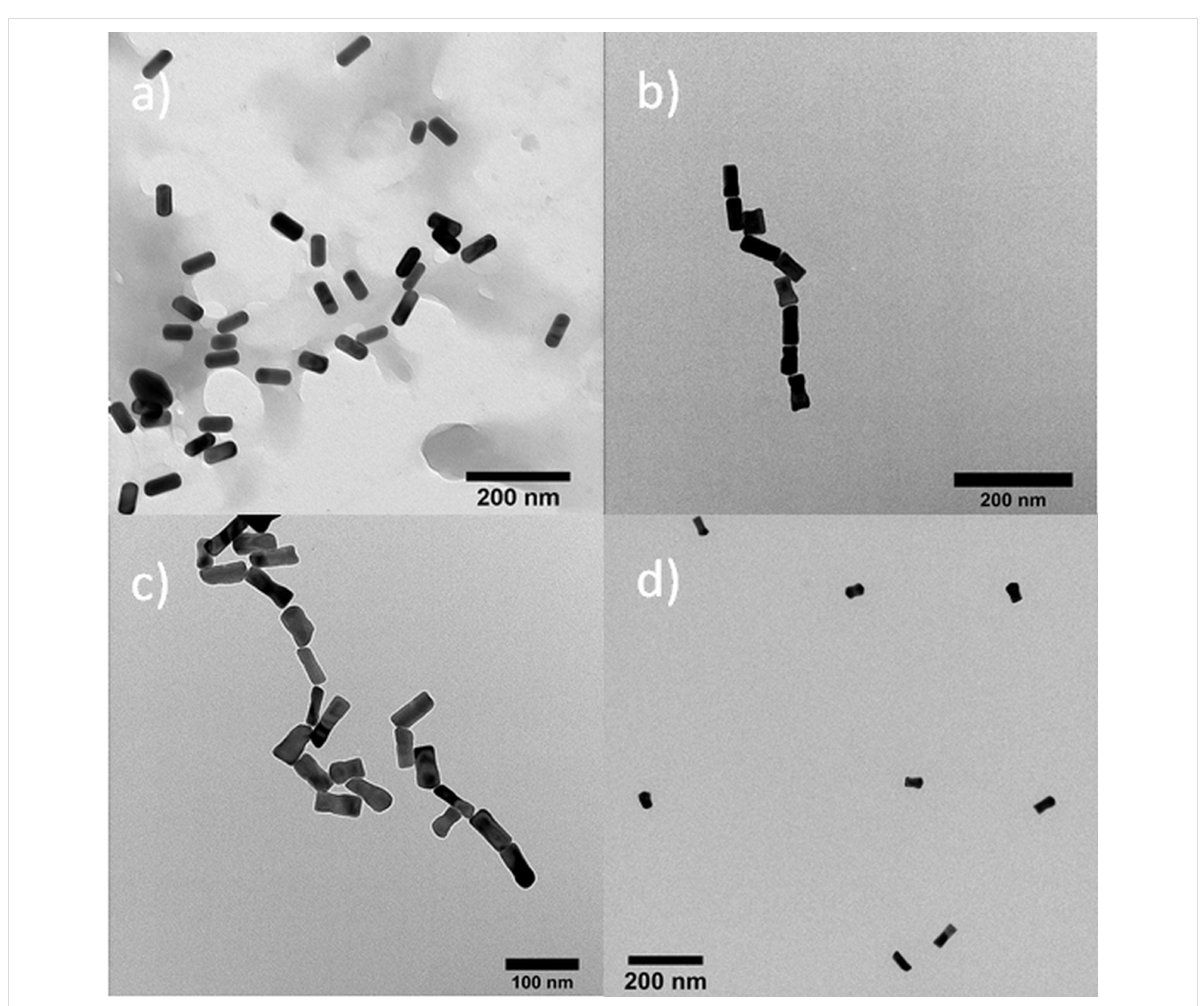
Figure 4: TEM-BF images of a) [tCD+tTEG]AuNR. b and c) AuNR end-to-end assemblies by dAAP (15 µM). d) Dissolved AuNR by UV irradiation ( λ = 360